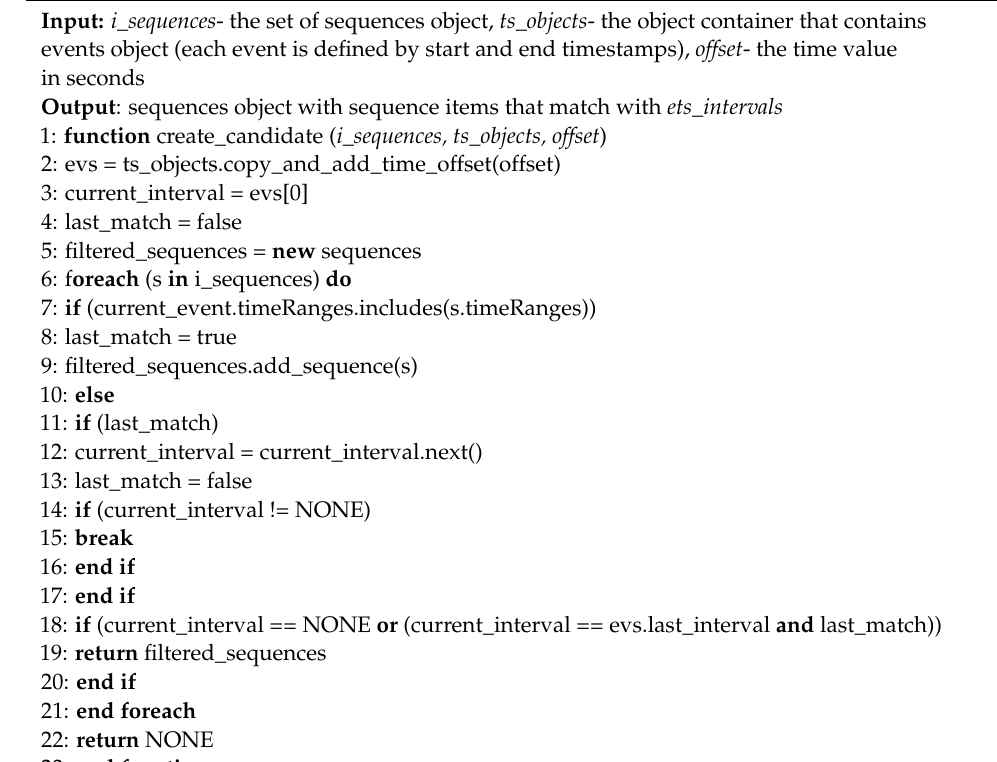
Algorithm 7 takes as the input the list of candidates in the form < offset, matched sequences >. It searches for an offset value with tolerance eps_tolerance to maximise